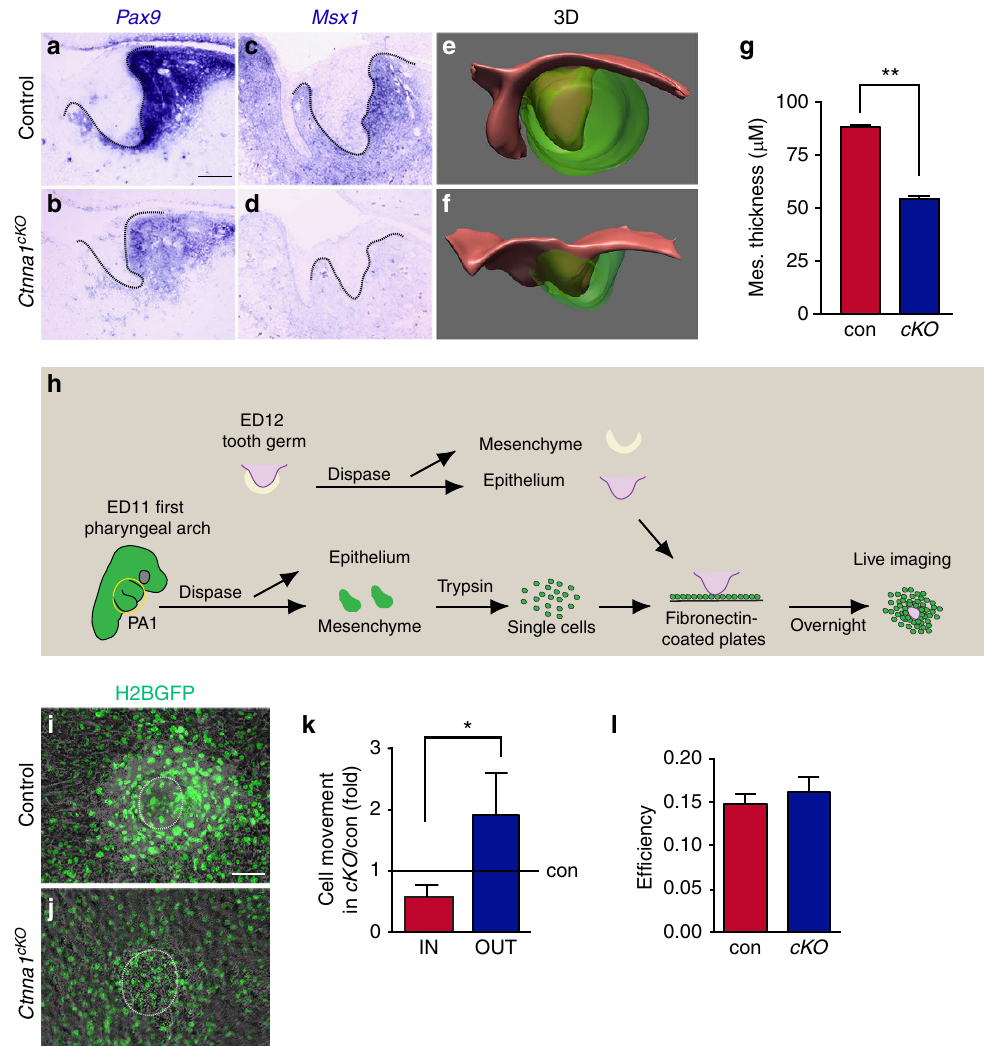
Figure 5 | a E-catenin is required for the epithelium-induced mesenchymal condensation during incisor development. ( a – d ) In situ hybridization for Pax9 and Msx1 in control and Ctnna1 cKO . In control embryos, Pax9 and Msx1 are expressed in the mesenchyme of the tooth germ at E13.5. In Ctnna1 cKO , the expression of these genes is reduced or absent. ( e , f ) 3D reconstruction of control and Ctnna1 cKO tooth germs at E13.5 (epithelium is red and mesenchyme is green). The thickness of the mesenchyme is reduced in the absence of a E-catenin. ( g ) Quantification of thickness of the condensed mesenchyme around the incisor dental epithelium at E13.5 (mean ± s.e.m., n ¼ 3, P o 0.01). ( h ) Schematic illustration of the in vitro condensation assay. ED, embryonic day;